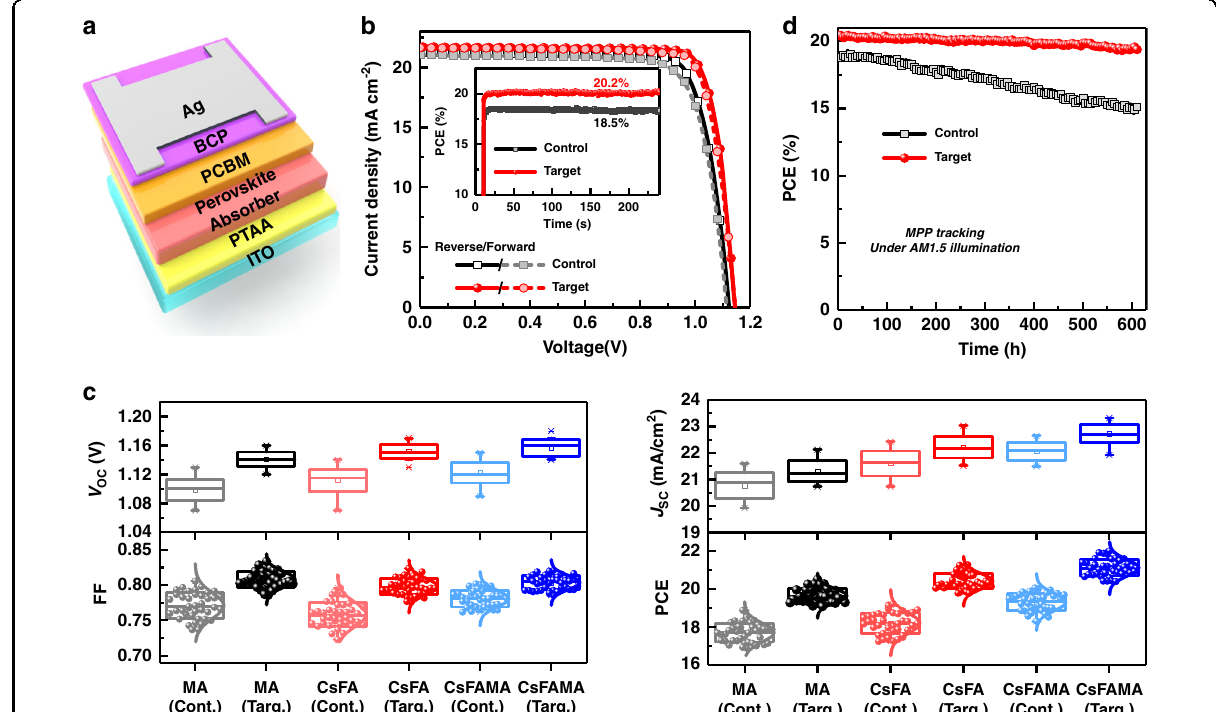
Fig. 2 Device performance characterization. a Schematic of the cell architecture used in this study. b Current density – voltage ( J – V ) curves of the champion MAPbI 3 -based control (with PAT additives) and target (with Au@PAT additives) devices. The inset shows steady-state PCE measurement results of the best control and target MAPbI 3 devices. c Statistical distributions of photovoltaic parameters for the control (Cont.) and target (Targ.) PSCs based on MAPbI 3 , CsFA, and CsFAMA perovskites (based on 40 separate measurements for each condition). d Long-term operational stability results of the control and target MAPbI 3 -based